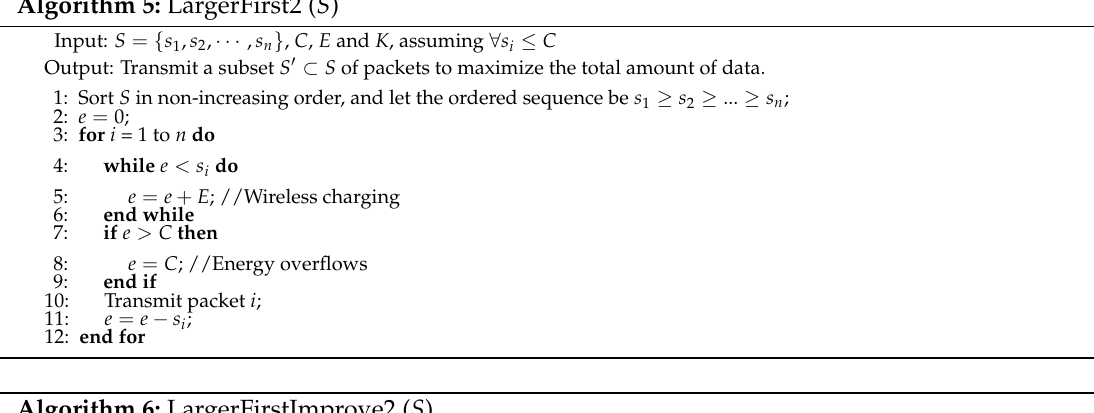
Algorithm 6: LargerFirstImprove2 ( S